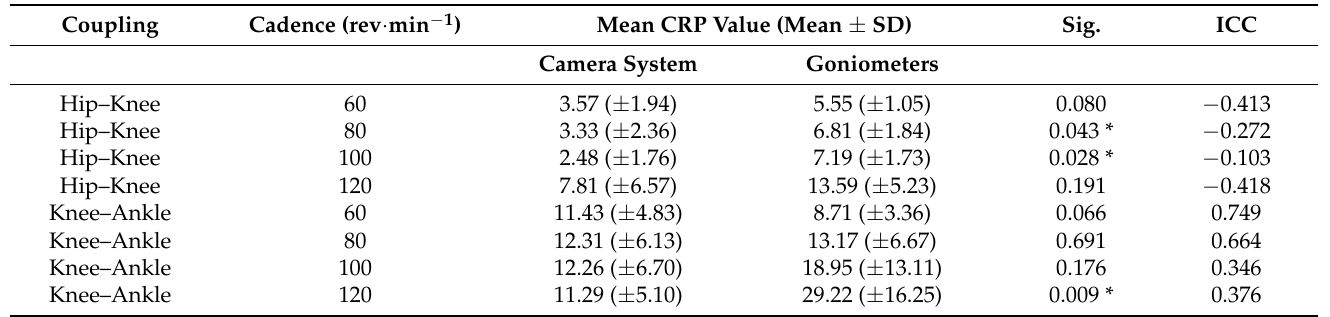
Table 1. Comparisons between mean continuous relative phase values produced across a complete pedal revolution.